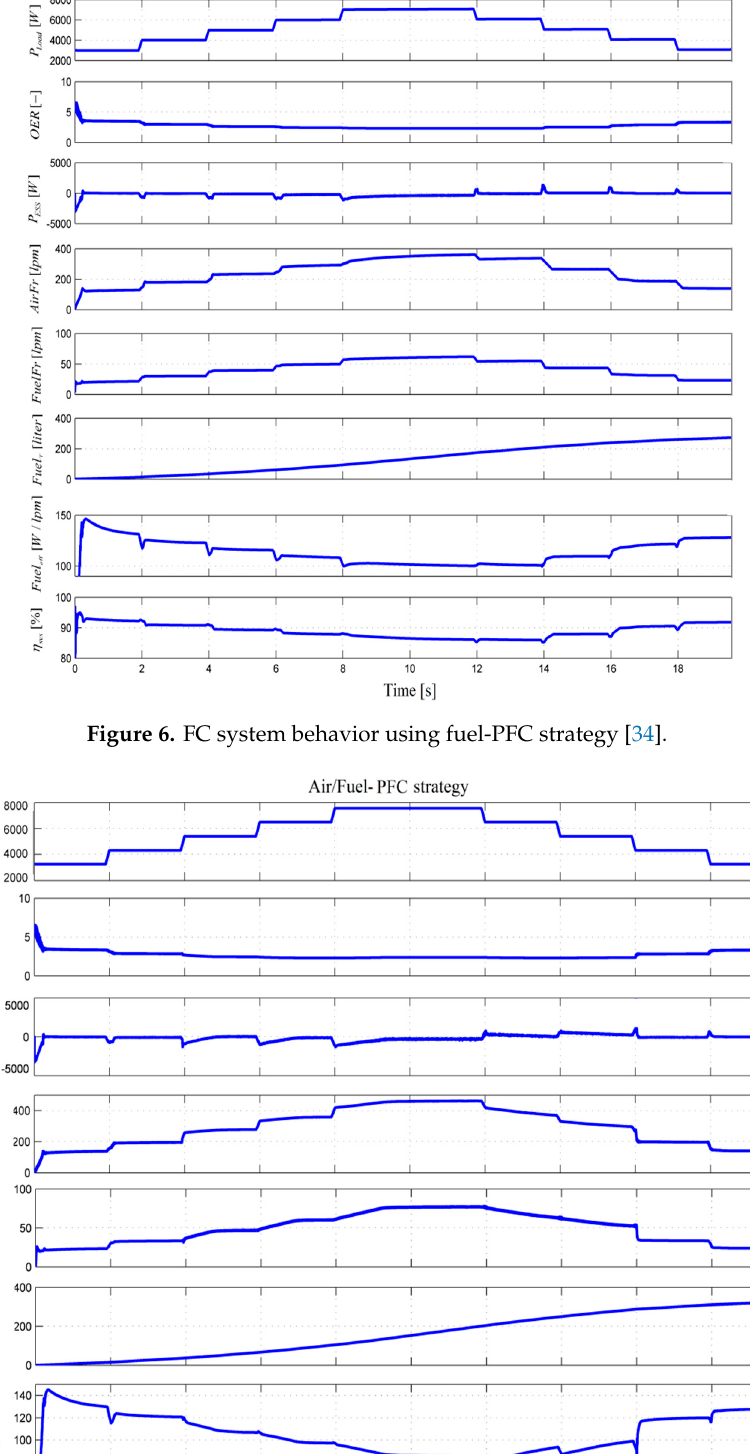
Figure 5. FC system behavior using air-PFC strategy [34].